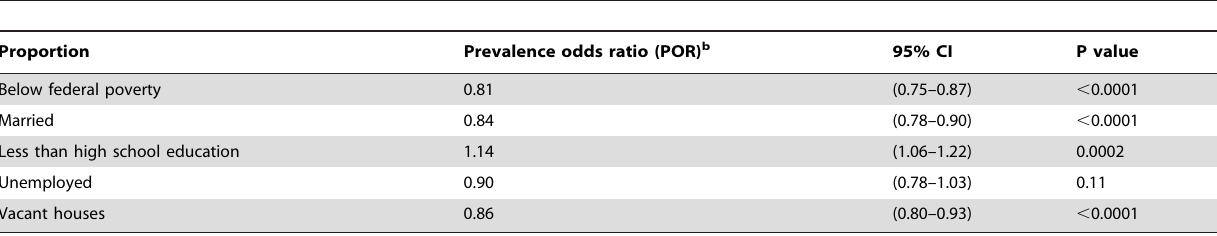
Table 3. Prevalence odds ratios a of HIV infection diagnosis for black/African American MSM vs. non-MSM, by selected census tract- level social determinants of health (SDH), 2005–2009—17